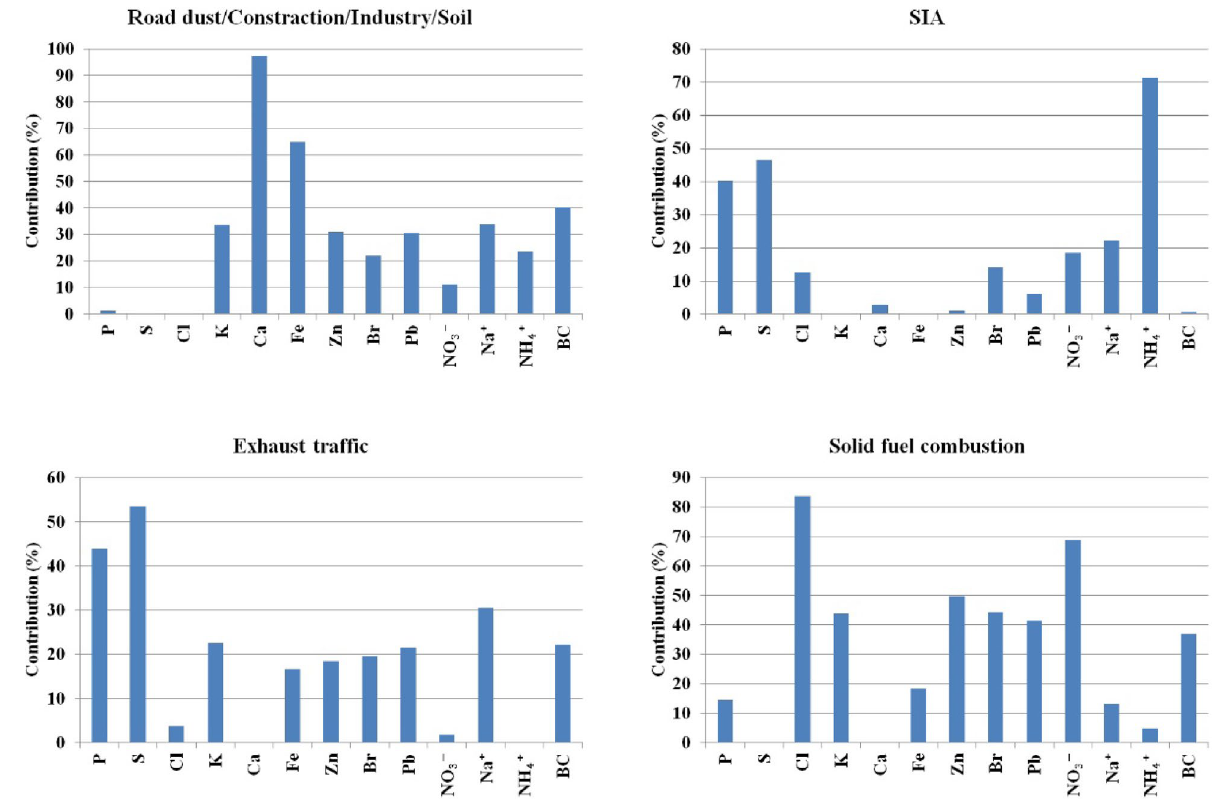
Figure 6. PMF factor profiles for